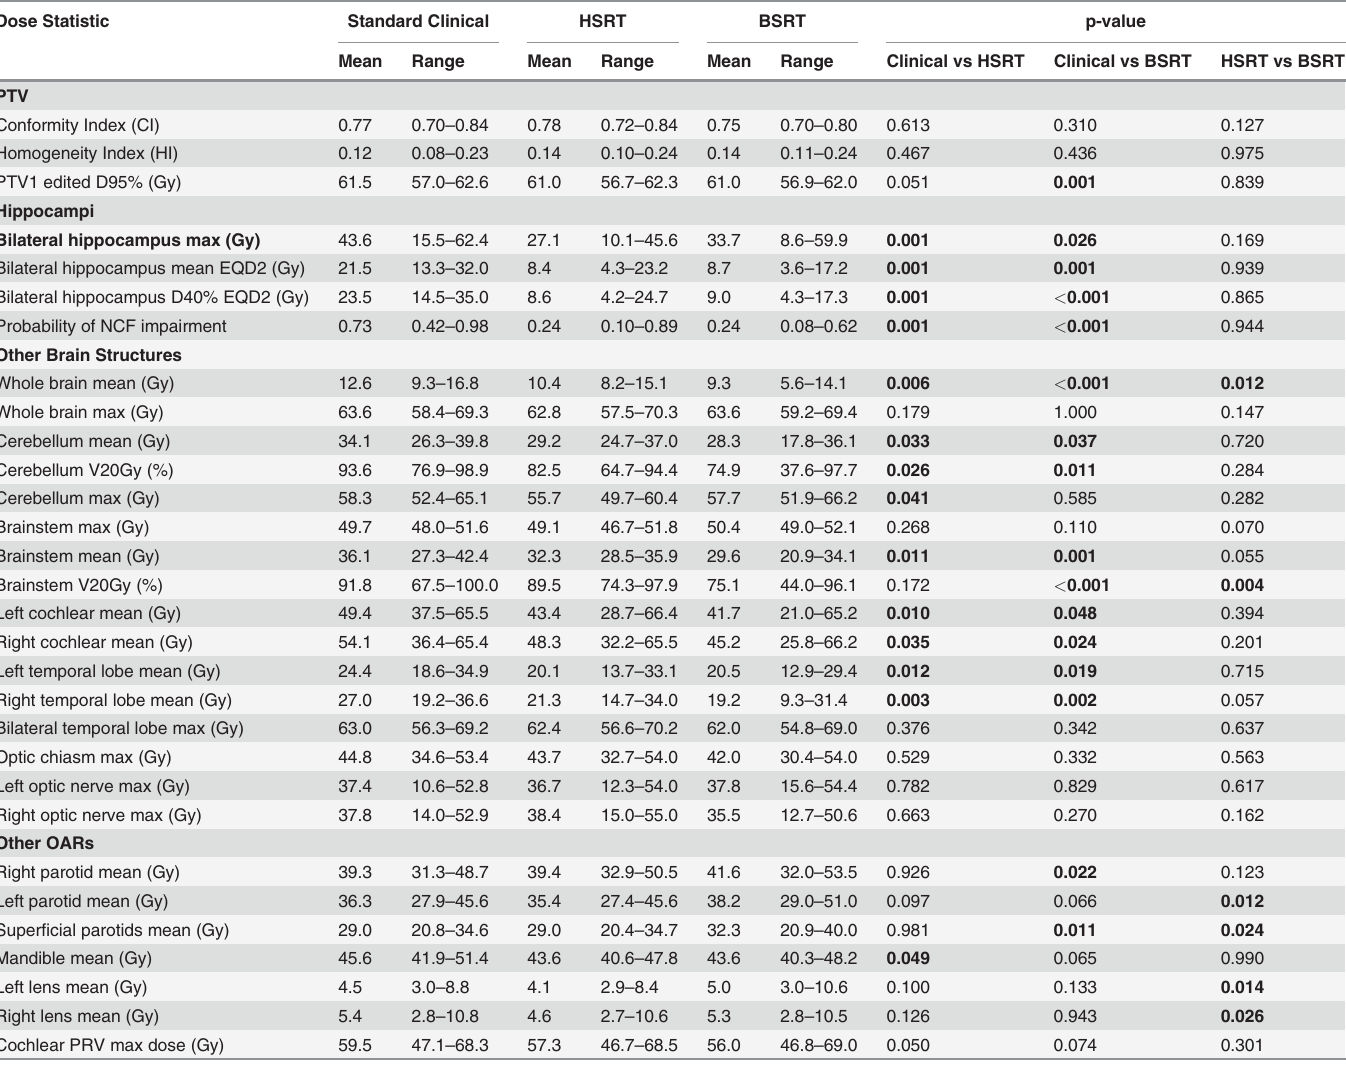
Table 2. Dose statistics for clinical, HSRT, and BSRT treatment plans for all 8 NPT